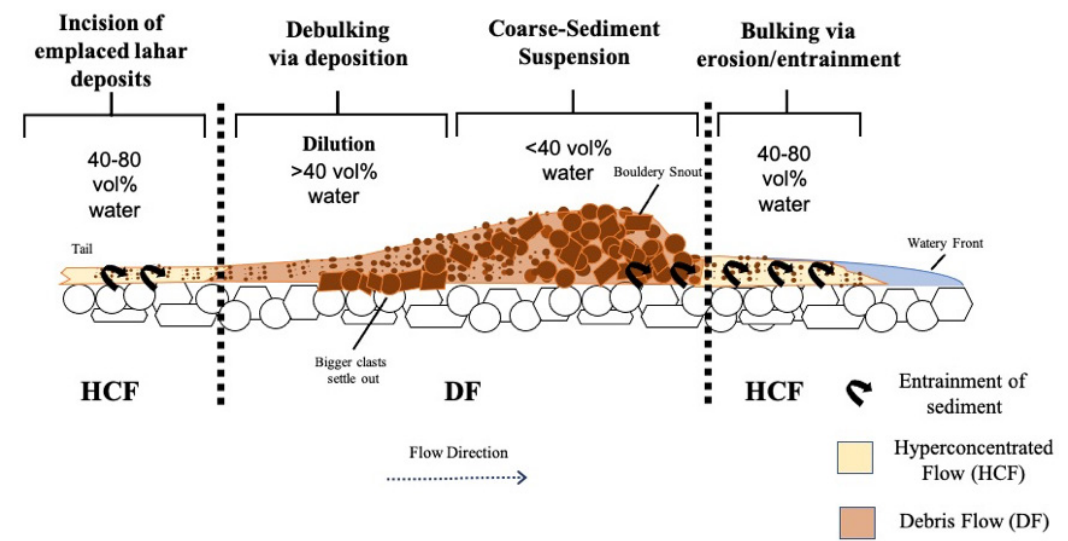
Figure 1: Schematic vertical profiles of lahar flow phases and pulses. Detailed flow properties of each small- scale pulse show a watery front, transitioning into hyperconcentrated flow (HCF) and debris flows (DF) as more sediment is entrained. Towards the tail of a pulse, the flow is more dilute and may transition back to a HCF or muddy streamflow, where free particles have a greater impact on channel walls, increasing erosive power, and entraining more sediment to transform back into a DF lahar. A lahar that has evolved will have multiple pulses that can be detected at different stations as the flow travels